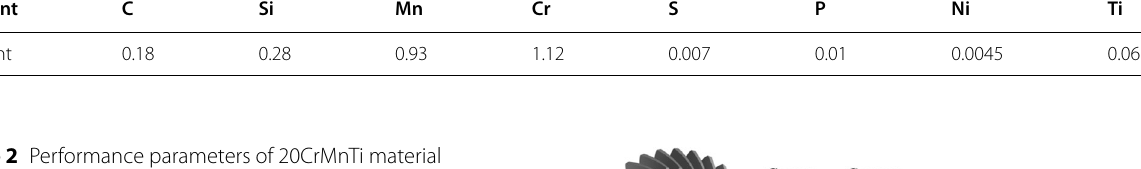
Table 2 Performance parameters of 20CrMnTi material Density ( kg/m 3 )